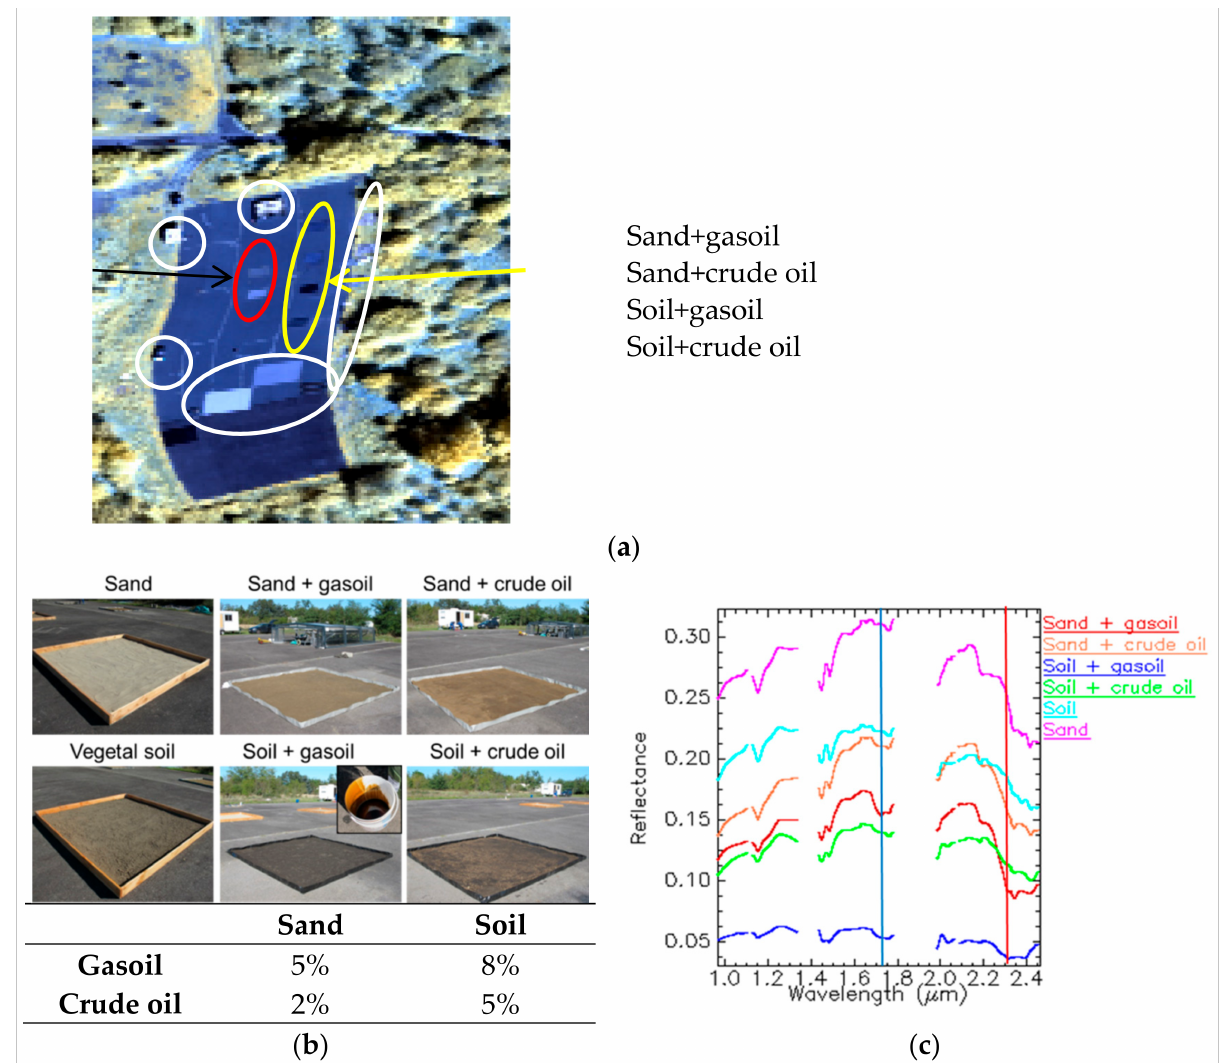
Figure 1. ( a ) Color composition of the proof of concept (POC) SWIR image. The red circle indicates boxes of pure sand and soil, boxes of hydrocarbon (HC) mixtures are in the yellow circle and plastic materials are in the white circles. ( b ) Boxes containing sand, soil, and hydrocarbons mixed with soil or sand. The table gives the volume percentage of hydrocarbon in the mixture. The white bucket contains crude oil. ( c ) Mean reflectance spectra of the six boxes extracted from the HySpex image. The blue and red vertical lines correspond to the HC absorption